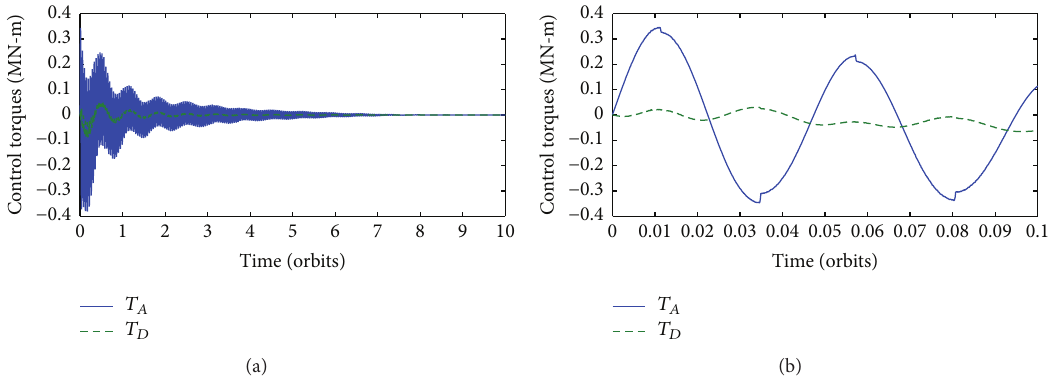
Figure 23: Control torques from the formulations based on point 𝐶 by applying the SDRE control with 𝛼 = 10 −6 for (a) the first 10 orbits and (b) the first 0.1